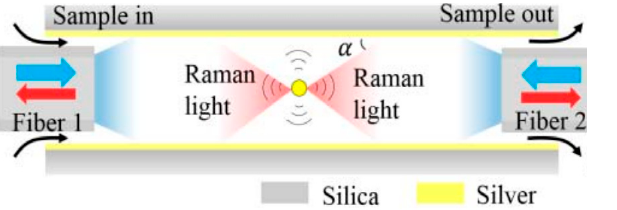
8 of 26 ( a ) ( b ) Figure 4. ( a ) Internal structure diagram of Bidatek Raman probe. ( b ) Detection principle diagram of MLHCF. Reproduced with permission [10]. When the excitation light is transmitted from the optical fiber to a position with a distance l from the optical fiber, the excitation light intensity I will be attenuated to I ∗ exp(−κ (cid:2869) l) . The reflected Raman light excited here will be attenuated to I ∗ exp(−κ (cid:2869) l) ∗ exp(−κ (cid:2870) l) . Considering that only the Raman light irradiated within the core diameter of the optical fiber and within its maximum receiving angle range can be received by the optical fiber, the receiving efficiency is η = (d/D) (cid:2870) ∗ (2π(1 − cosα)/4π) ∗ (Ω (cid:2925)(cid:2912)(cid:2920) /Ω (cid:2916)(cid:2919)(cid:2912)(cid:2915)(cid:2928) ), where d is the fiber core diameter, D is the inner diameter of the HCF, α is the maximum acceptance angle of the fiber, Ω (cid:2916)(cid:2919)(cid:2912)(cid:2915)(cid:2928) and Ω (cid:2925)(cid:2912)(cid:2920) are the solid angles corresponding to the NA of the lens and the fiber, respectively. The intensity of the reflected Raman signal and transmitted Raman signal received by the Raman probe in the structure of Figure 4b can be expressed by Equations (3) and (4). Compared with the direct detection, the Raman signal can be significantly enhanced by using the structure with MLHCF. P (cid:2902) = (cid:3505) σmπ(D 2) (cid:2870) ηI (cid:2868) exp(−κ (cid:2869) l)exp(−κ (cid:2870) l)dl (cid:2896) (cid:2868) (3) P (cid:2904) = (cid:3505) σmπ(D 2) (cid:2870) ηI (cid:2868) exp(−κ (cid:2869) l)exp[−κ (cid:2870) (2L − l)]dl (cid:2896) (cid:2868)